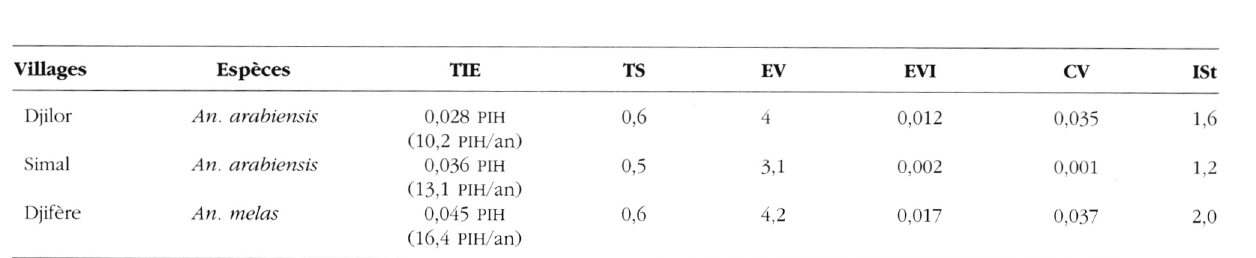
Espérance de vie infectante ; CV = Capa-